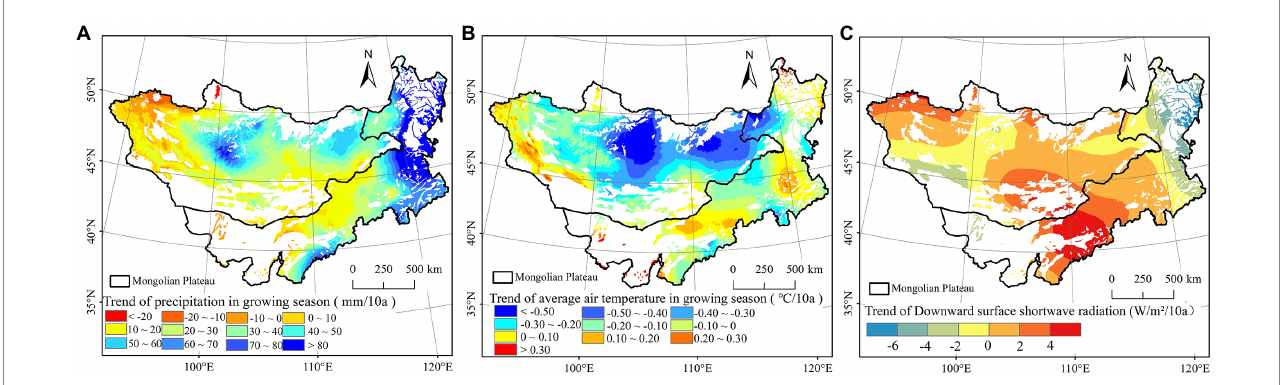
FIGURE 4 Temporal and spatial variation trend of growing season meteorological factors for grassland vegetation on Mongolian Plateau from 2000 to 2018. (A) Trend of precipitation in growing season (mm/10a), (B) Trend of air temperature in growing season (°C/10a), (C) Trend of downward surface shortwave in growing season (W/m²/10a).